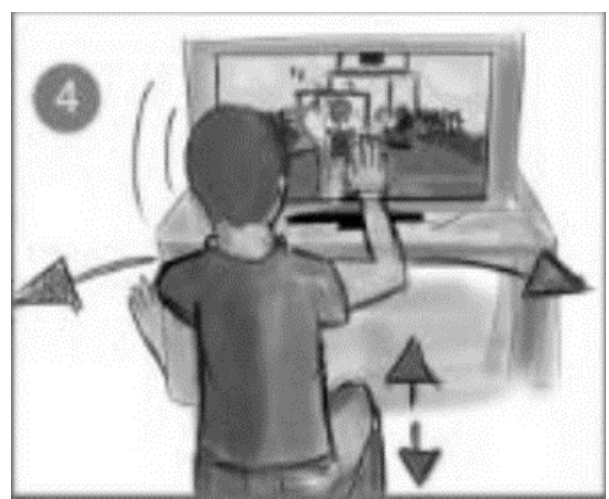
Figure 5. Design of the interaction with the game control device.